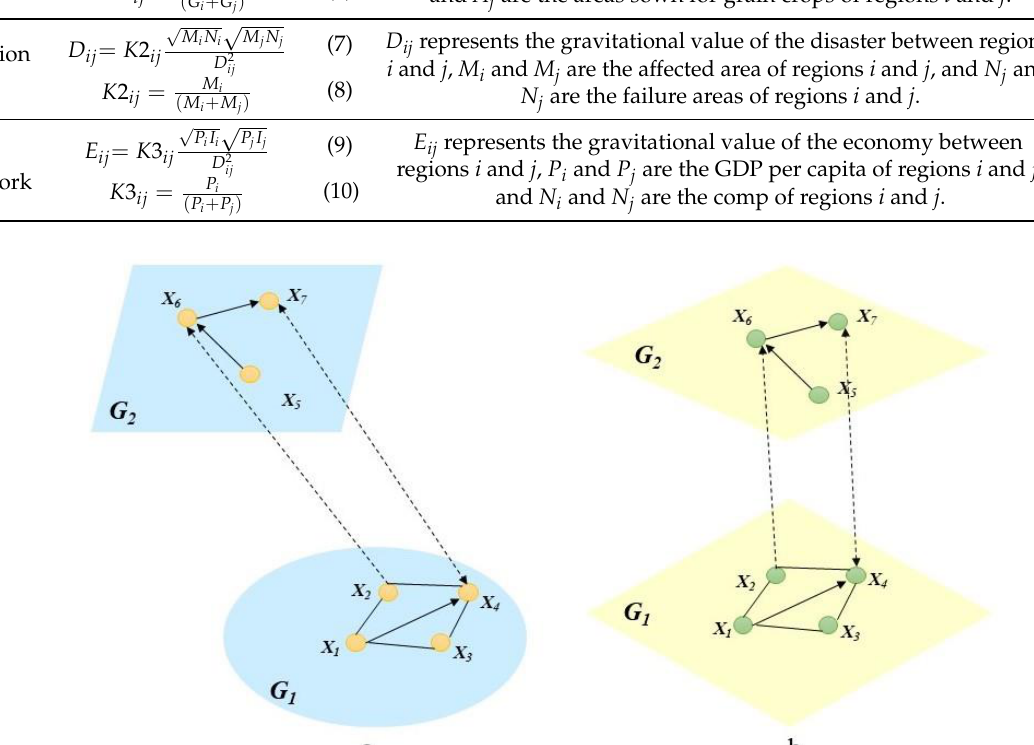
Figure 2. Schematic representation of the transformation of two interacting networks into a multilayer network. ( a ) networks with interactions ( b ) the structure of a multilayer network consisting of these two interacting networks. ( G 1 and G 2 represent the two layers of the network respectively, the black solid line represents the interaction of the nodes within the layers, and the black dashed line represents the interaction of the nodes between the layers).